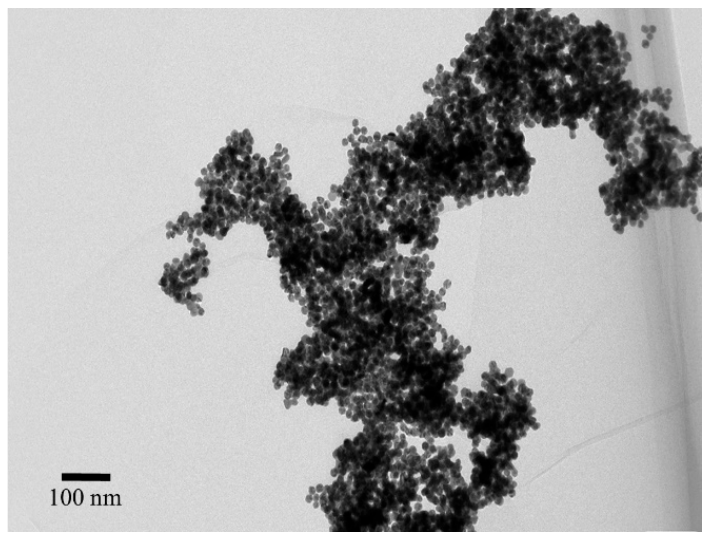
Figure 7. HR-TEM image of the aggregated stage of AuNPs.